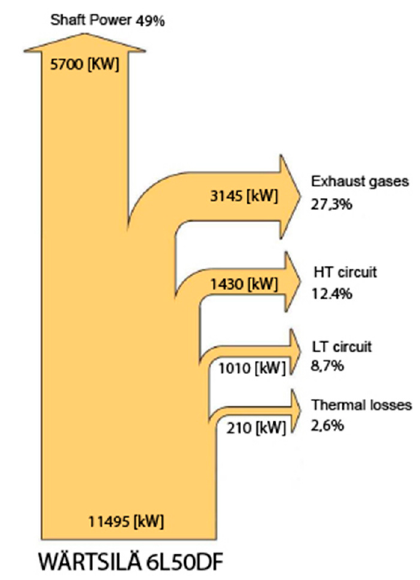
Figure 1. Energy balance of the engine W6L50DF [1].